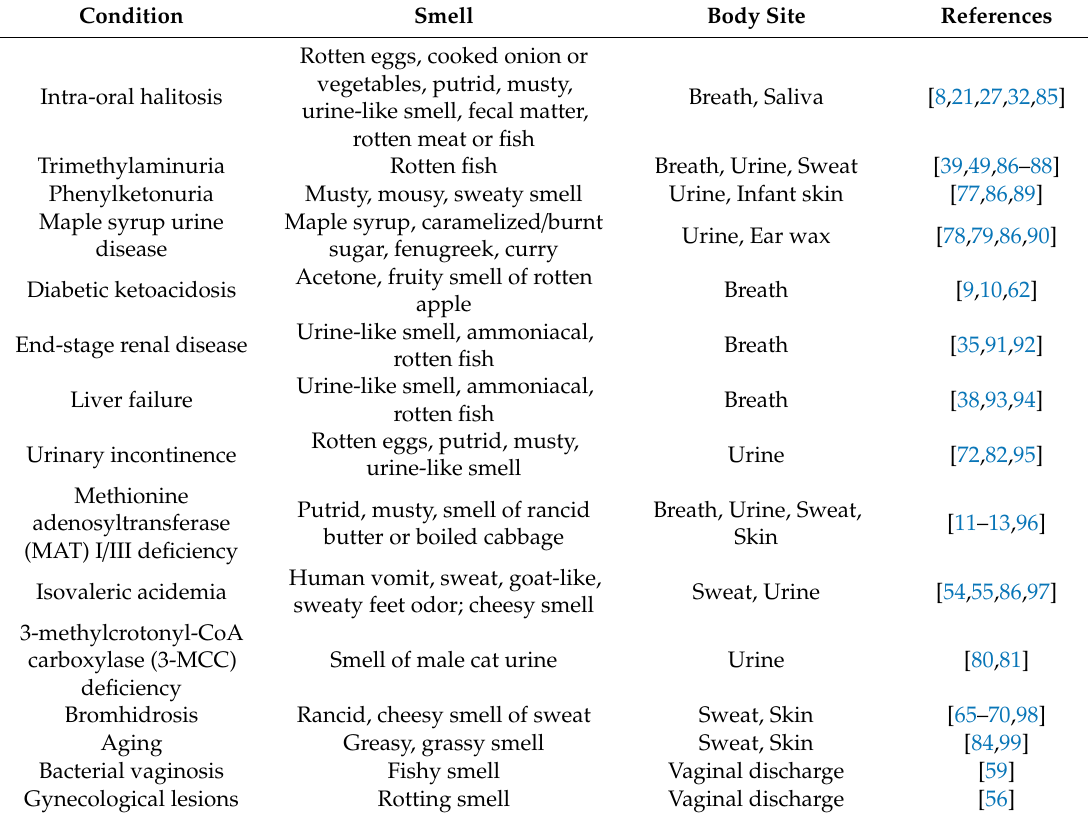
Table 2. Conditions associated with